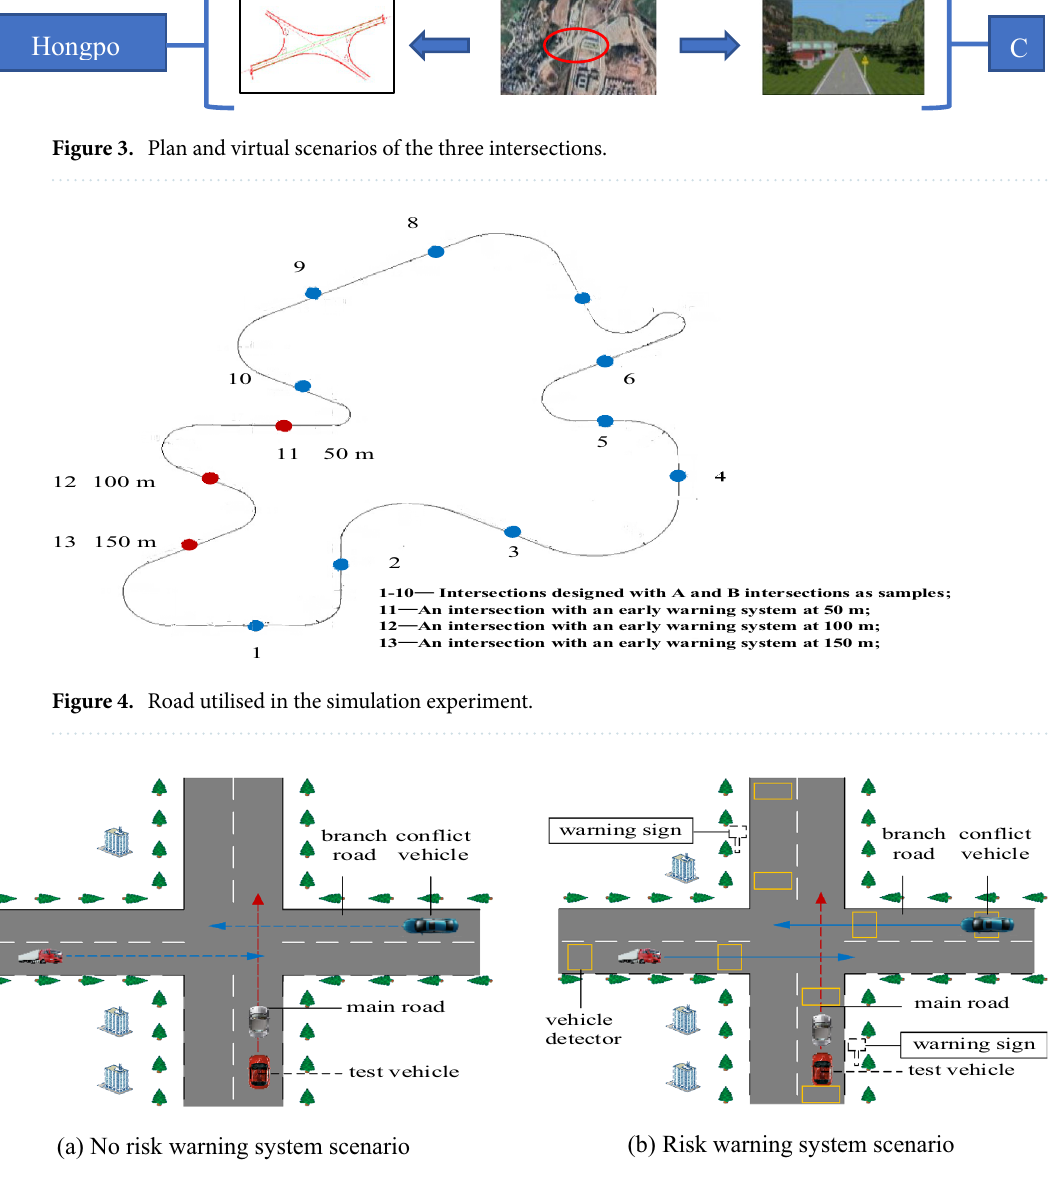
Figure 5. Intersection experiment